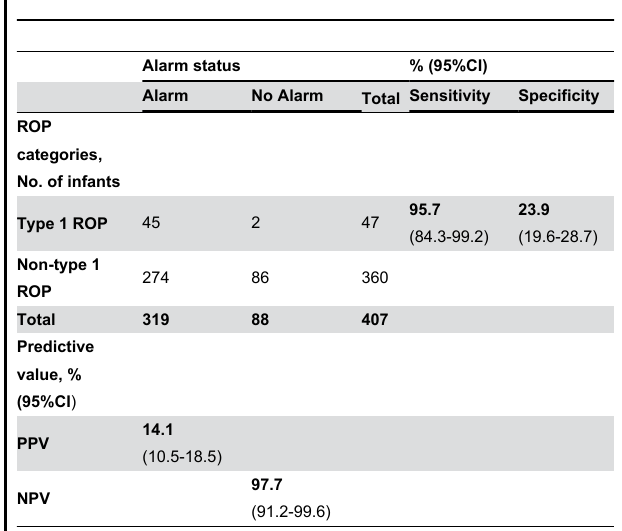
Table 2. WINROP Sensitivity, Specificity, Positive and Negative Predictive Values in Identifying Type 1